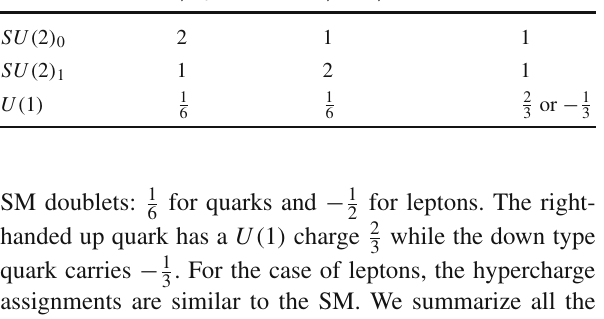
Table1 Fermioniccharge assignmentsinthemodel –inadditiontothe SM-like left-handed doublets and right-handed SU ( 2 ) singlets, there is also a right-handed fermion doublet under SU ( 2 ) 1 ψ L